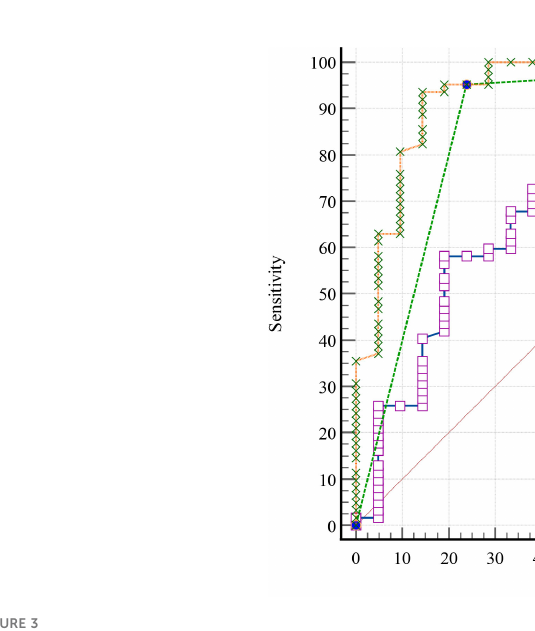
FIGURE 3 ROC curves of different indexes.